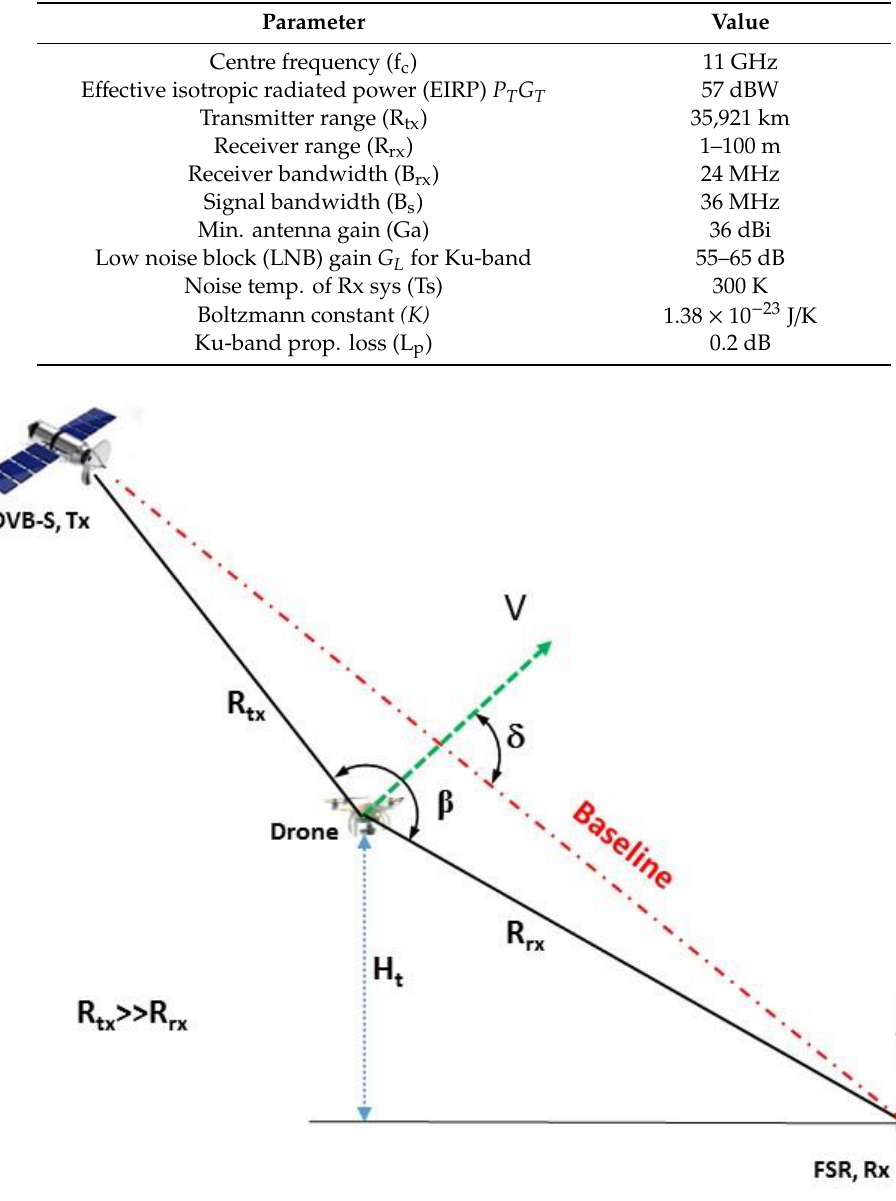
Figure 1. DVB-S-based passive FSR geometry.